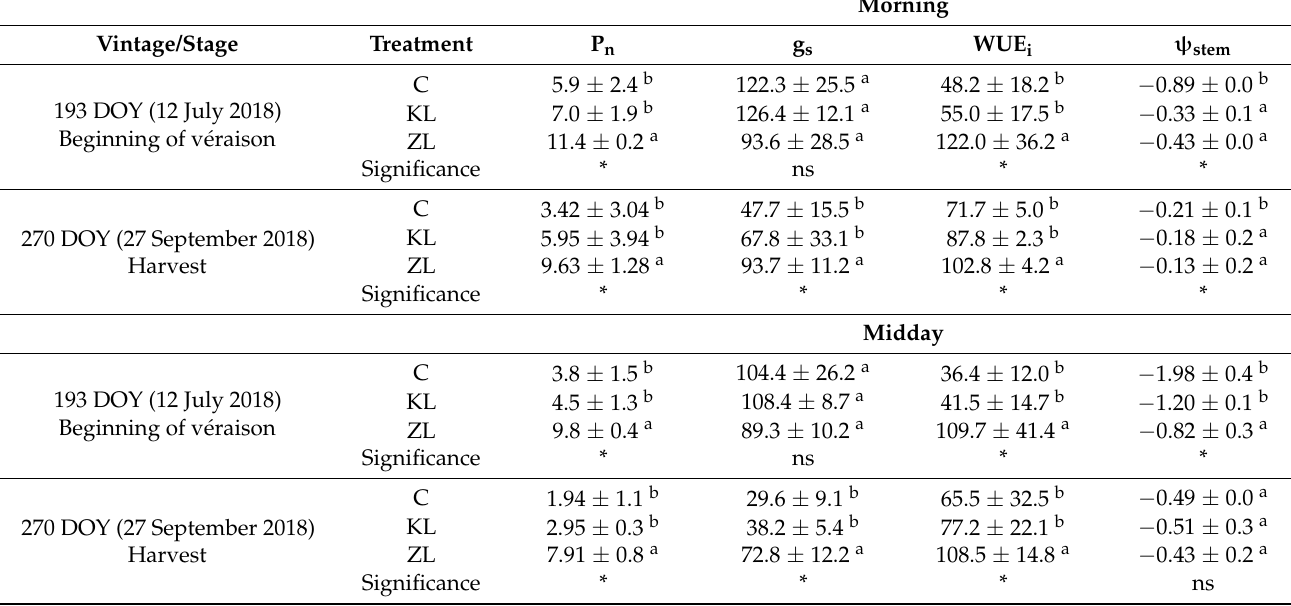
Table 2. Grapevine physiological parameters. Net photosynthesis (P n , µ mol m − 2 s − 1 ),